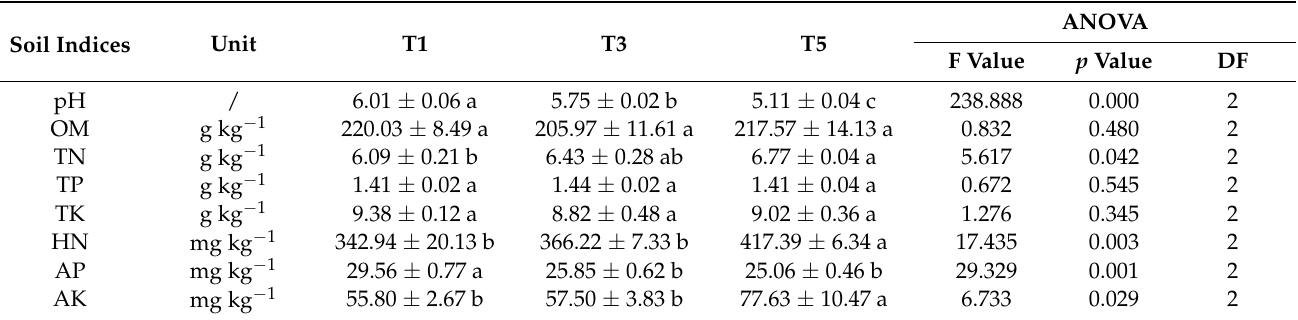
Table 2. Soil physicochemical indices in the rhizosphere of C. grandiflora supplemented with 0 (T1), 2 (T3), and 8 (T5) g kg − 1